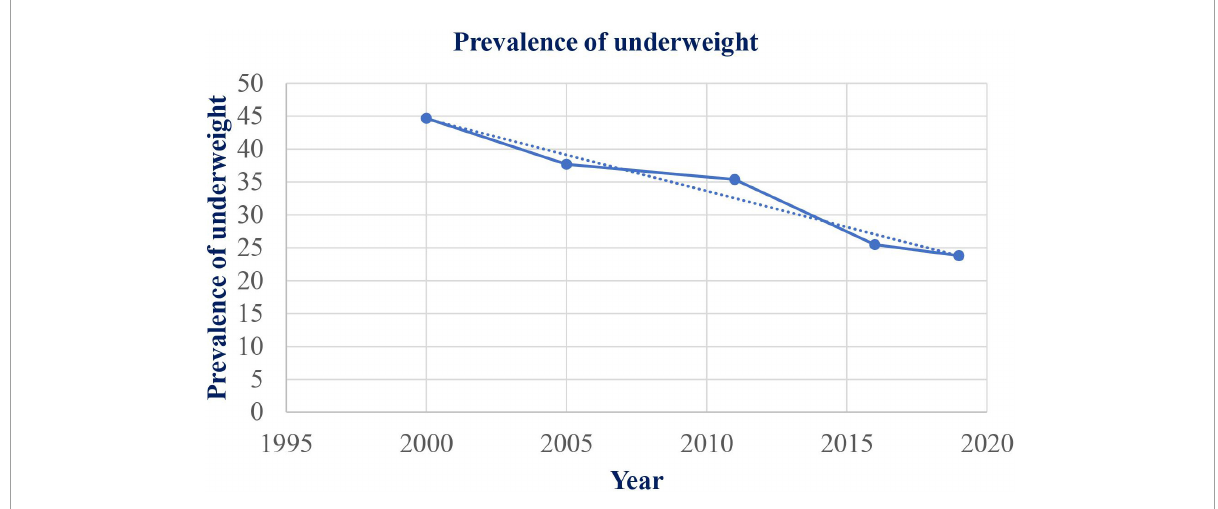
FIGURE1 Trends of underweight among under-five children in Ethiopia between 2000 and